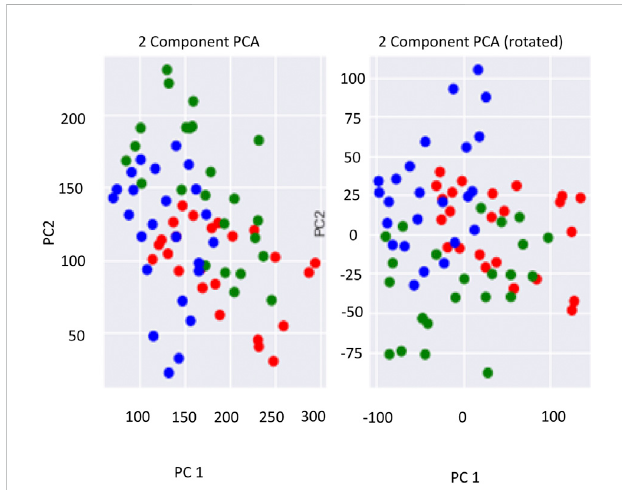
FIGURE 7 Two-component principal component analysis of the parameters for the three lakes. The green rounded circles represent Prashar Lake; theredroundedcirclesrepresentKuntbhyogLake,andthebluerounded circles represent Rewalsar